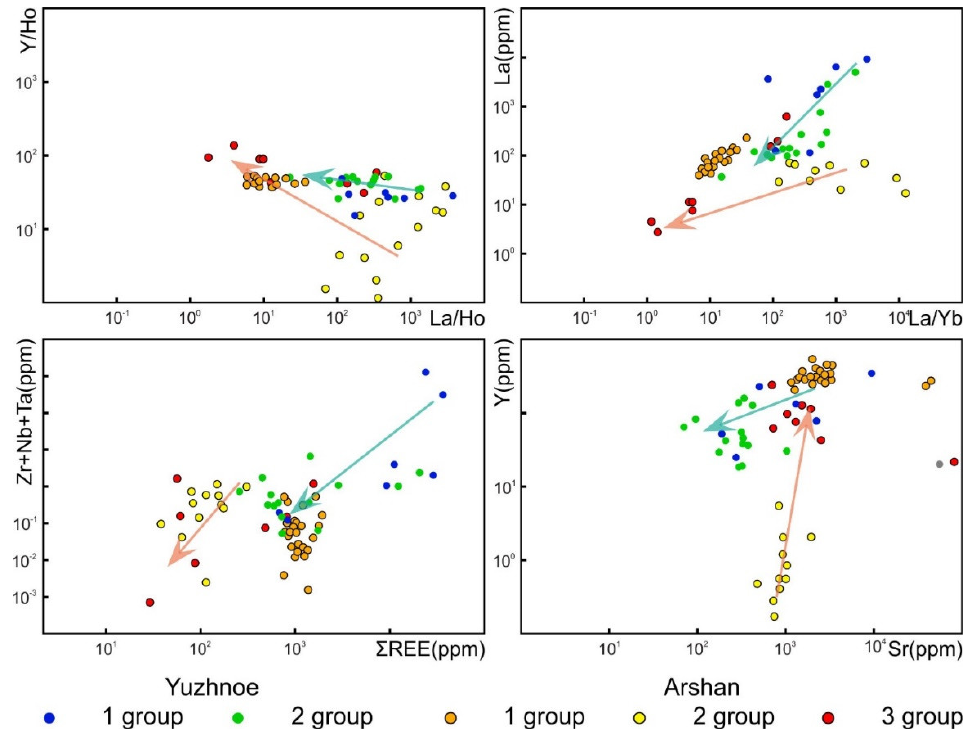
Figure 4. Groups of fluorites from Arshan and Yuzhnoe occurrences. Arrows indicate changes in the geochemical characteristics of fluorites from early to late for the Arshan and Yuzhnoye occur- rences.